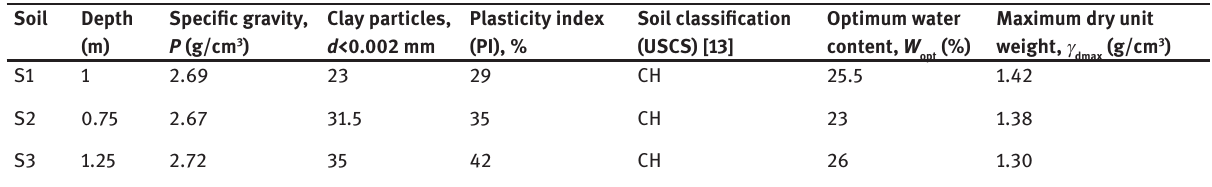
Table 1: Basic properties of the studied clayey soils. Soil Depth